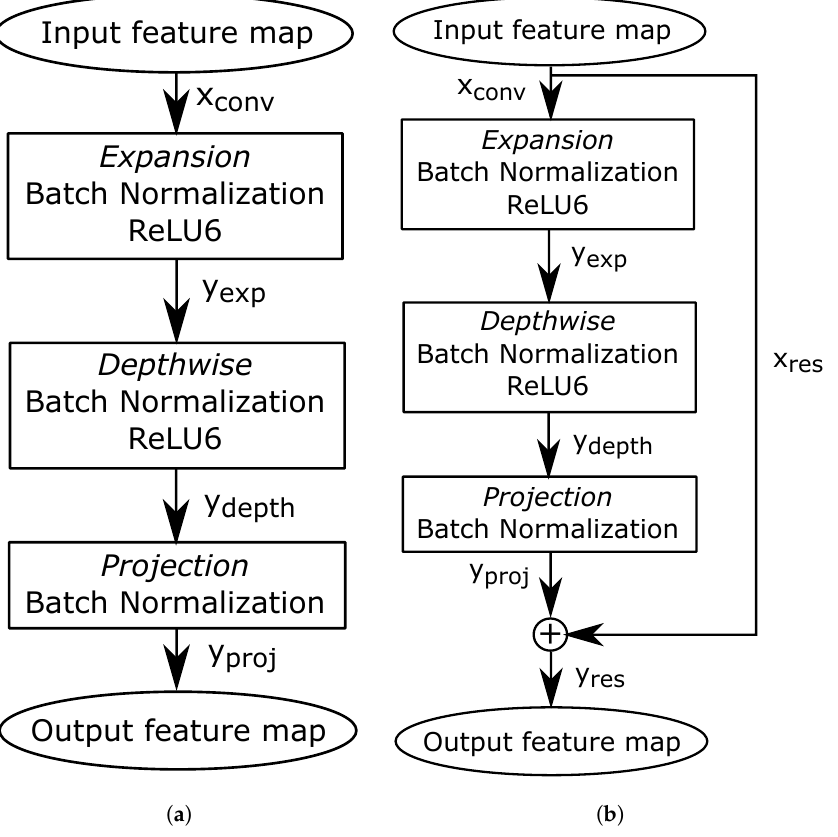
Figure 2. Bottleneck blocks. ( a ) bottleneck block without residual layer; ( b ) bottleneck block with residual